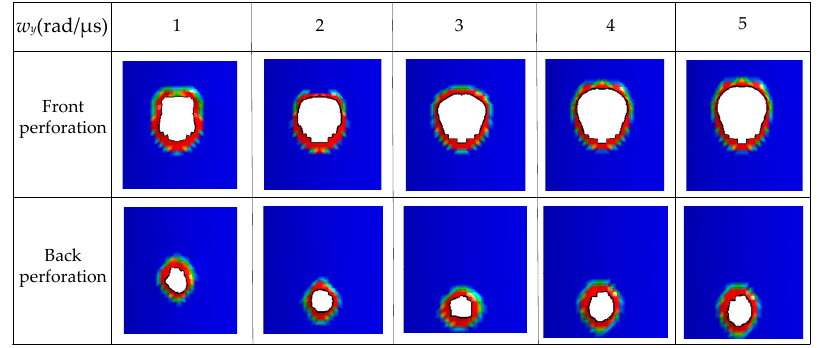
Figure 18. Front and back perforations caused by the impact of debris with angular velocities of w y = 1 rad / µ s, w y = 2 rad / µ s, w y = 3 rad / µ s, w y = 4 rad / µ s, and w y = 5 rad / µ s.